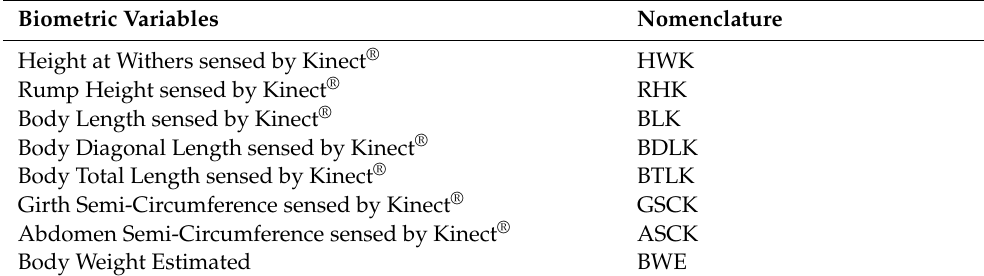
Table 1. Biometric variables used as elements of the polynomial model. Biometric